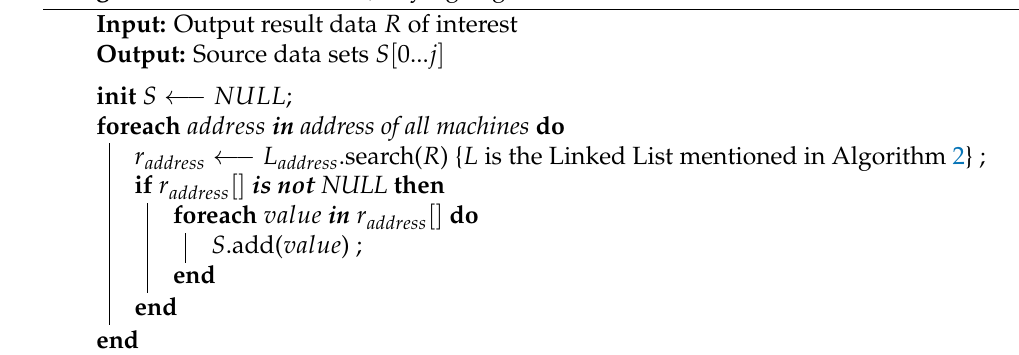
Algorithm 3: Provenance Querying Algorithm in Online